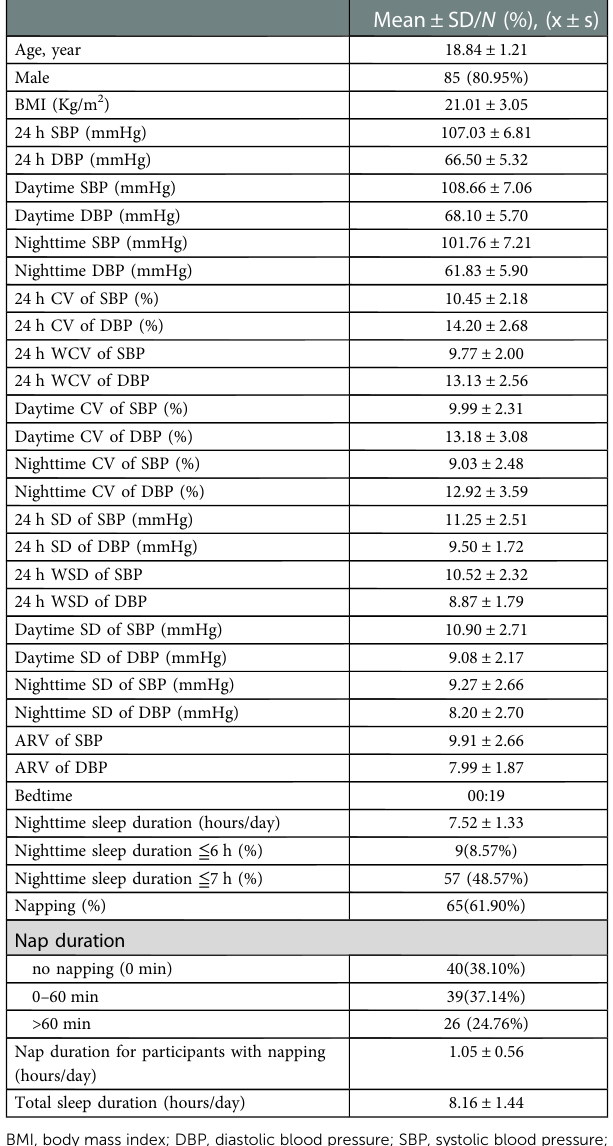
TABLE 1 General characteristics of